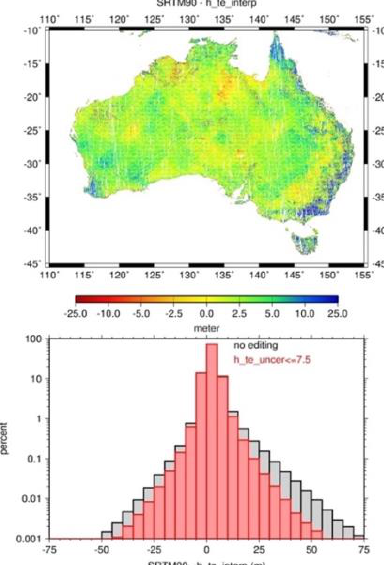
Figure 1. Differences between SRTM 90 m and ATL08 h_te_interp . Histograms show distributions for unedited data (gray) and data edited for h_te_uncertainty  7.5 m (red).